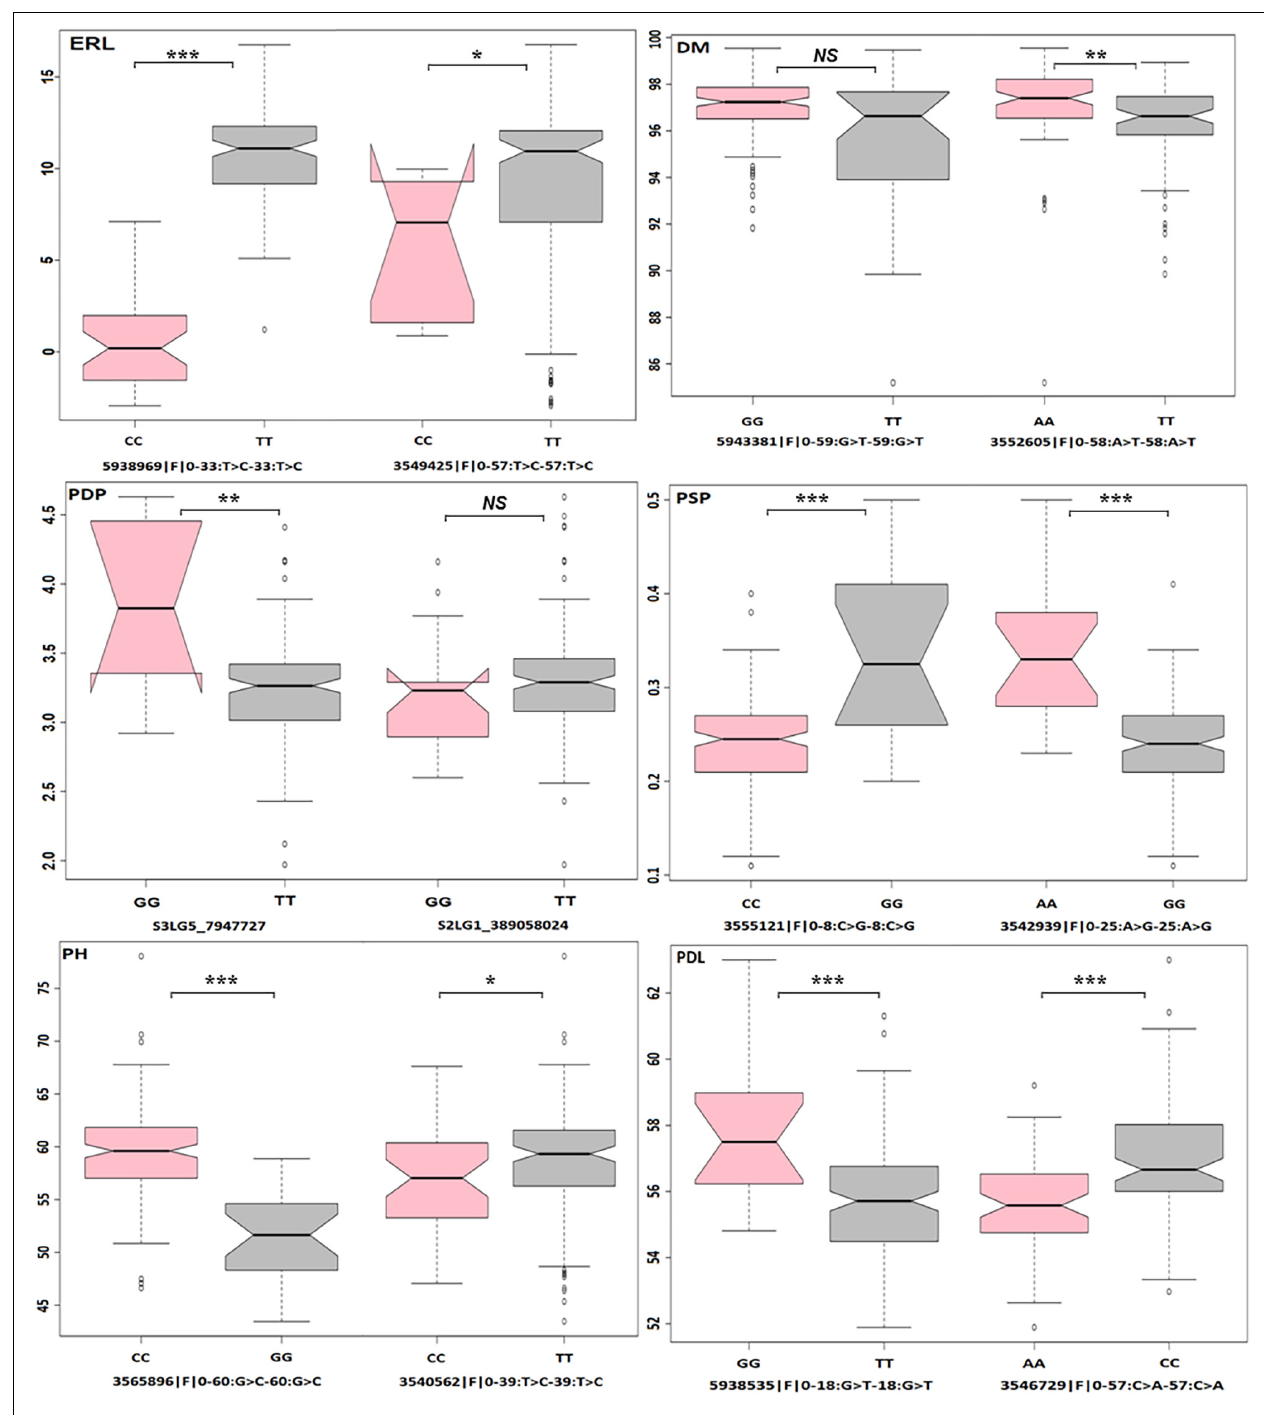
FIGURE 6 | Allelic effects of the top two SNPs with significant marker-trait associations (MTAs) on the estimated BLUPs of phenotypic records of six traits. Earliness (ERL), downy mildew (DM), the number of pods per plant (PDP), percent of small, wrinkled vining peas (PSP), plant height (PH), pod length (PDL). * P < 0.05; ** P < 0.01; *** P < 0.001; NS,